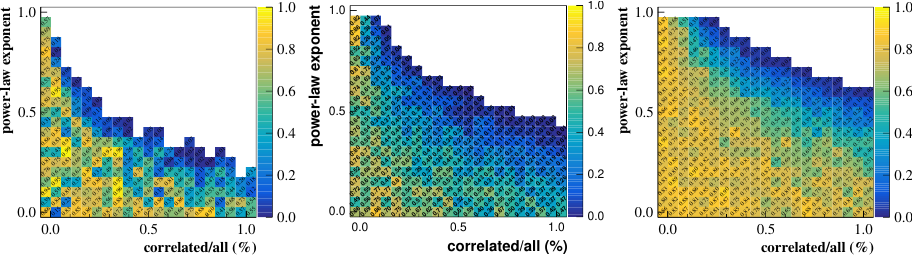
Figure 5. Exclusion plot, the p-values, for the Power-law Model parameters – the fraction of corre- lated protons and the power-law exponent. The white areas correspond to p-values less than 1%. The exclusion plot for 208 Pb + Pb at 13 A GeV/ c , 208 Pb + Pb at 30 A GeV/ c and 40 Ar + 45 Sc at 150 A GeV/ c are shown from left to right . Exclusion plots for other data sets are expected